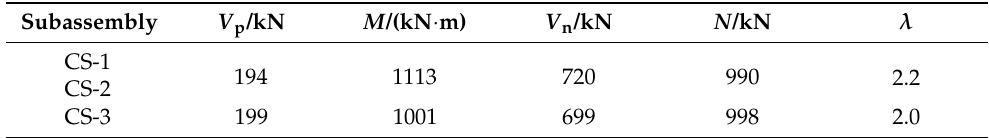
Figure 7. Flexural capacity calculating diagram. Table 1. Calculated capacities and shear-span ratios.